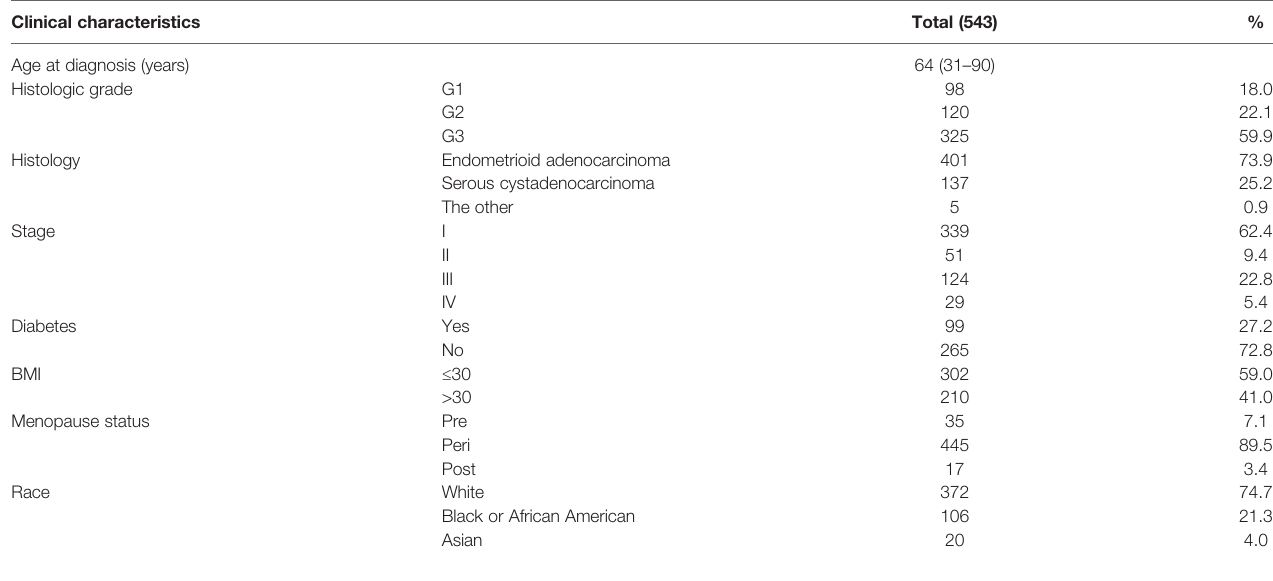
TABLE 1 | TCGA endometrial carcinoma patient